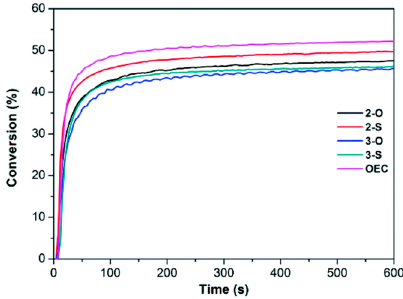
Figure 21. Monomer conversions obtained during the FRP of TMPTA using different oxime esters, irradiation at 450 nm with a LED (30 mW/cm 2 ). Reproduced with permission of Ref. [191] .